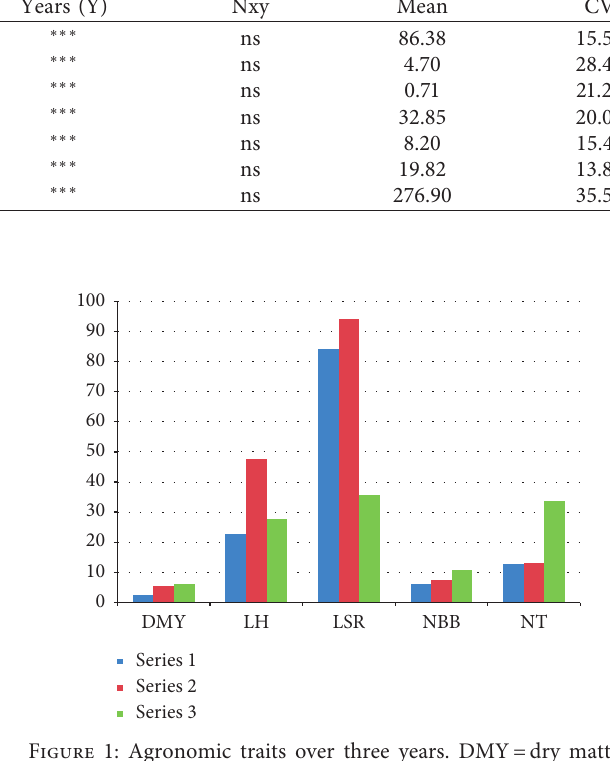
Table 1: Effects of years of planting and interaction on measured agronomic traits of Chloris gayana. S. no.